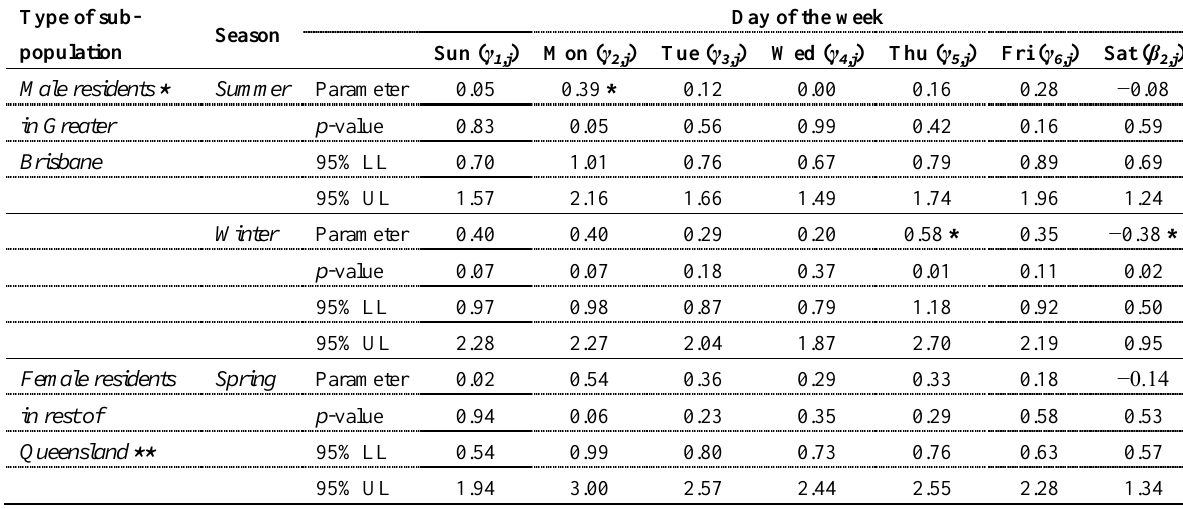
Table 2. Regression analysis to examine seasonal differences in the day-of-the-week pattern of suicide for selected groups in Queensland,